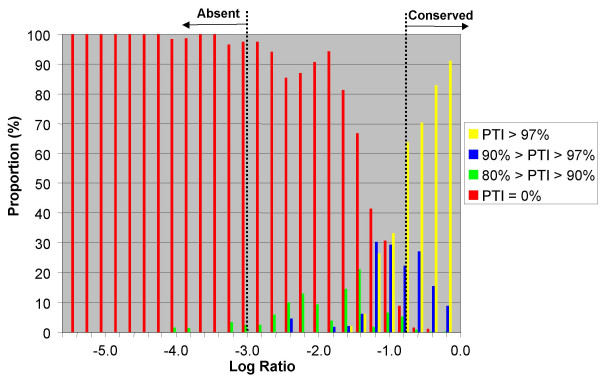
Determination of thresholds for absent and conserved genes. We calculated the proportion of genes belonging to each of four PTI categories at 0.2 LR intervals in order to determine LR thresholds that could be used to predict absent and conserved genes with a high degree of certainty. Below a LR of -3.0, the false positive rate for conserved genes is less than 1%; similarly, the false positive rate for absent genes above LRs of -0.8 is also less than 1%. In the LR interval between -3.0 and -0.8, particularly approaching the -0.8 boundary, there are significant number of genes from more than one PTI category and thus there is significant risk of misclassification.